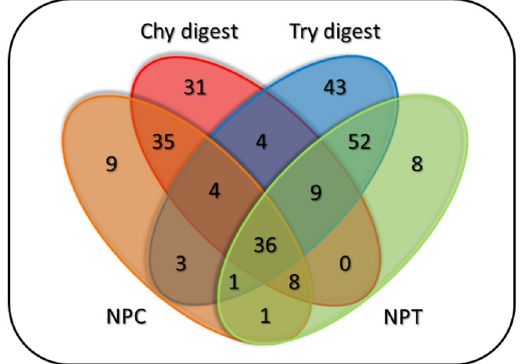
Figure 4. Venn diagram showing the number of individually labelled sites of TMPs from the HL60 cells, separated by enzymes and their treatment time. Chy digest and Try digest: merged chymotrypsin and trypsin pre-digested samples [10–20 min and 15–25 min, respectively]. NPC and NPT: control samples for chymotrypsin and trypsin enzyme treatments, respectively.